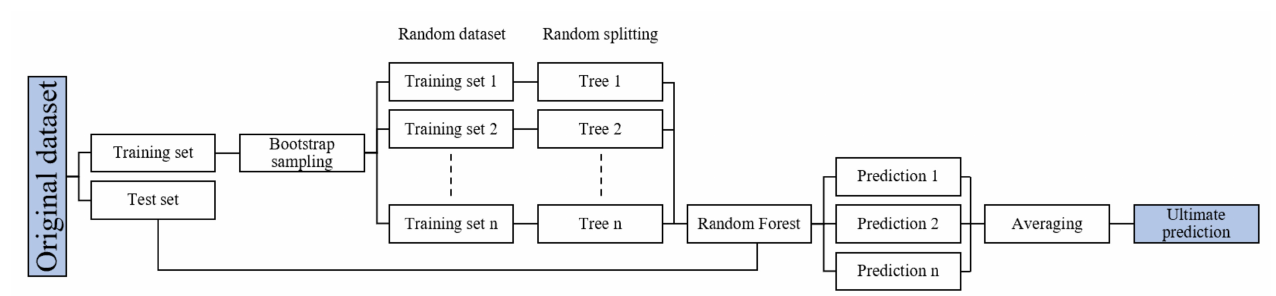
Figure 3. Structure of